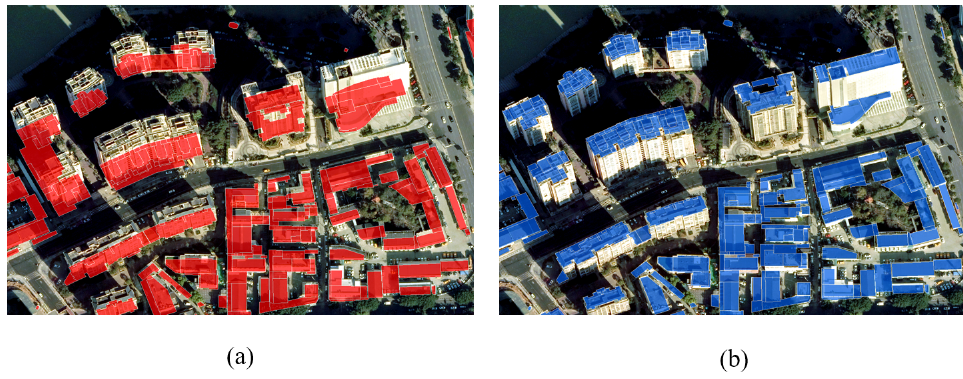
Figure 1. ( a ) Noise-containing building labels, where the red label does not match the roof of the building, are marked on the side of the building, especially in high-rise buildings; ( b ) corrected building label, where the blue label matches the building roof